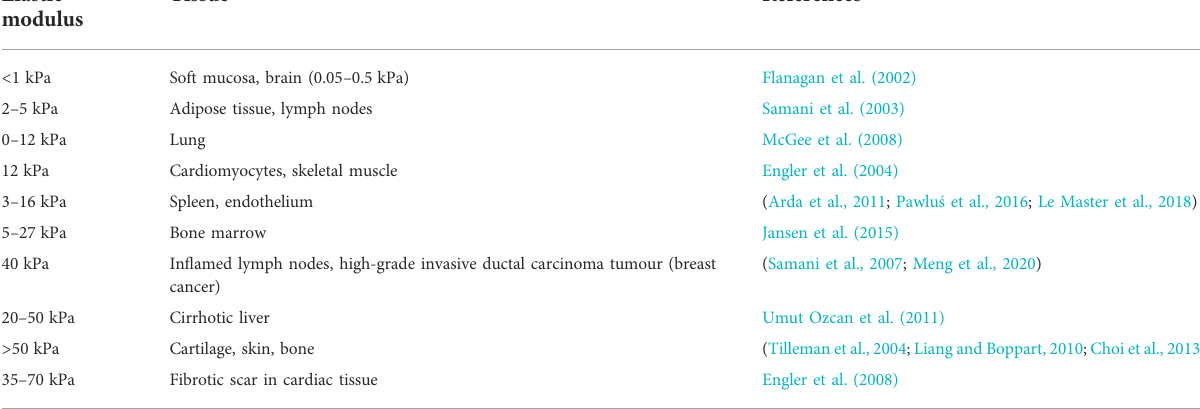
TABLE 1 Elastic moduli of tissues. Elastic